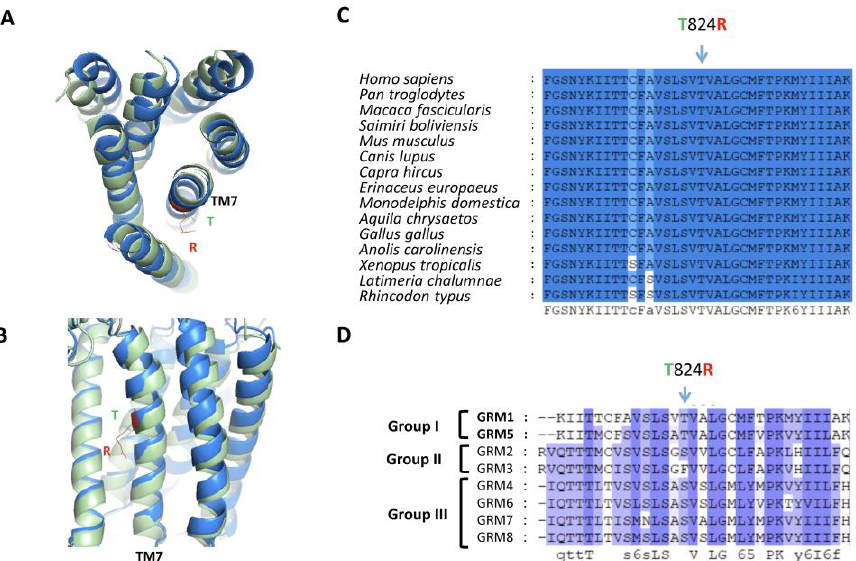
Figure 2. Analysis of p.Thr824Arg (T824R) amino acid substitution effect on the mGluR1 protein structure. ( A , B )—Alignment of the spatial structure of the wild-type (green) and mutated (blue) transmembrane domain containing the p.Thr824Arg amino acid substitution in a patient AIV-1. Protein spatial structure predicted by Phyre2 [33]. ( C , D )—Evolutionary analysis of the conservation of the mGluR1 protein region among orthologs ( C ) and paralogs ( D ).